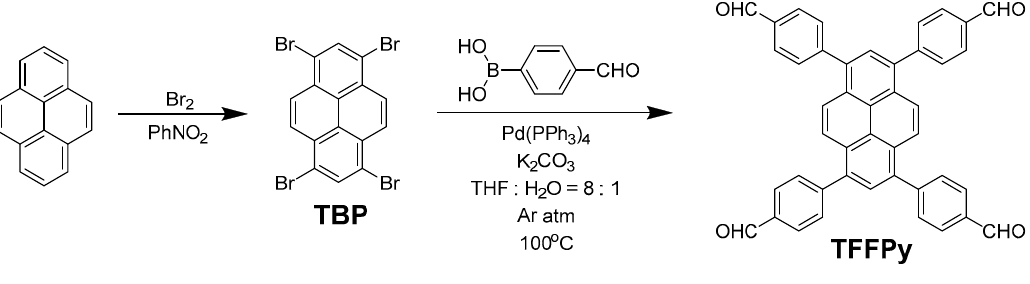
Figure 1. The preparation of TFFPy.